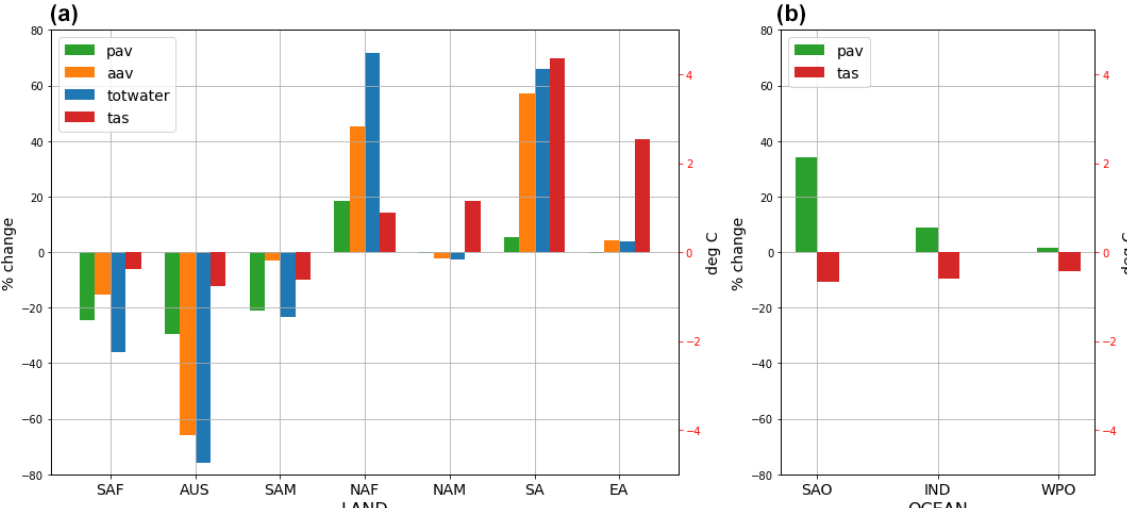
Figure 7. Changes in monsoon season (NH: MJJAS; SH: NDJFM) precipitation averaged within (a) terrestrial monsoon domains shown in Fig. 6 and (b) over SH ocean regions. Areas in which individual monsoon and ocean regions are bounded as defined in Table S1. Pav: percent- age change in area-averaged precipitation rate during monsoon season. Aav: percentage change in areal extent of regional monsoon domain. Totwater: percentage change in total precipitated water during monsoon season (mean precipitation rate over monsoon domain multiplied by areal extent). TAS: air surface temperature (in ◦ C). Key: SAF = South African monsoon; AUS = Australian monsoon; SAM = South Amer- ican monsoon; NAF: North African monsoon; NAM = North American monsoon; SA = South Asian monsoon; EA = East Asian monsoon; SAO = South Atlantic Ocean; IND = southern Indian Ocean; WPO = western to central Equatorial Pacific Ocean.